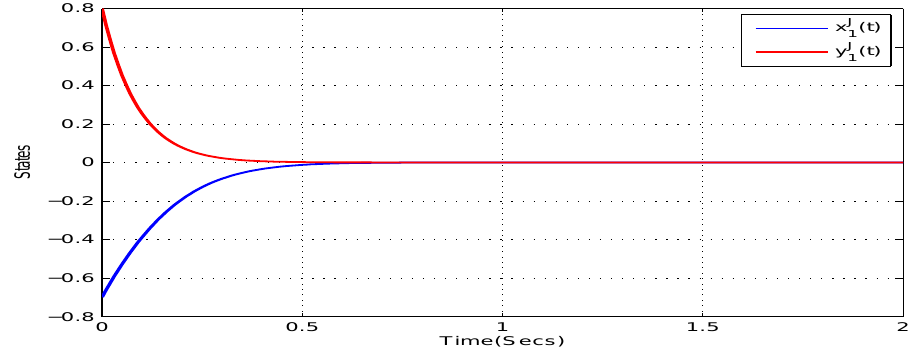
Figure 5. An illustration of the time responses with respect to the imaginary part pertaining to the states of ( t ) in Example 2. ( t ) , y J x J 1 1